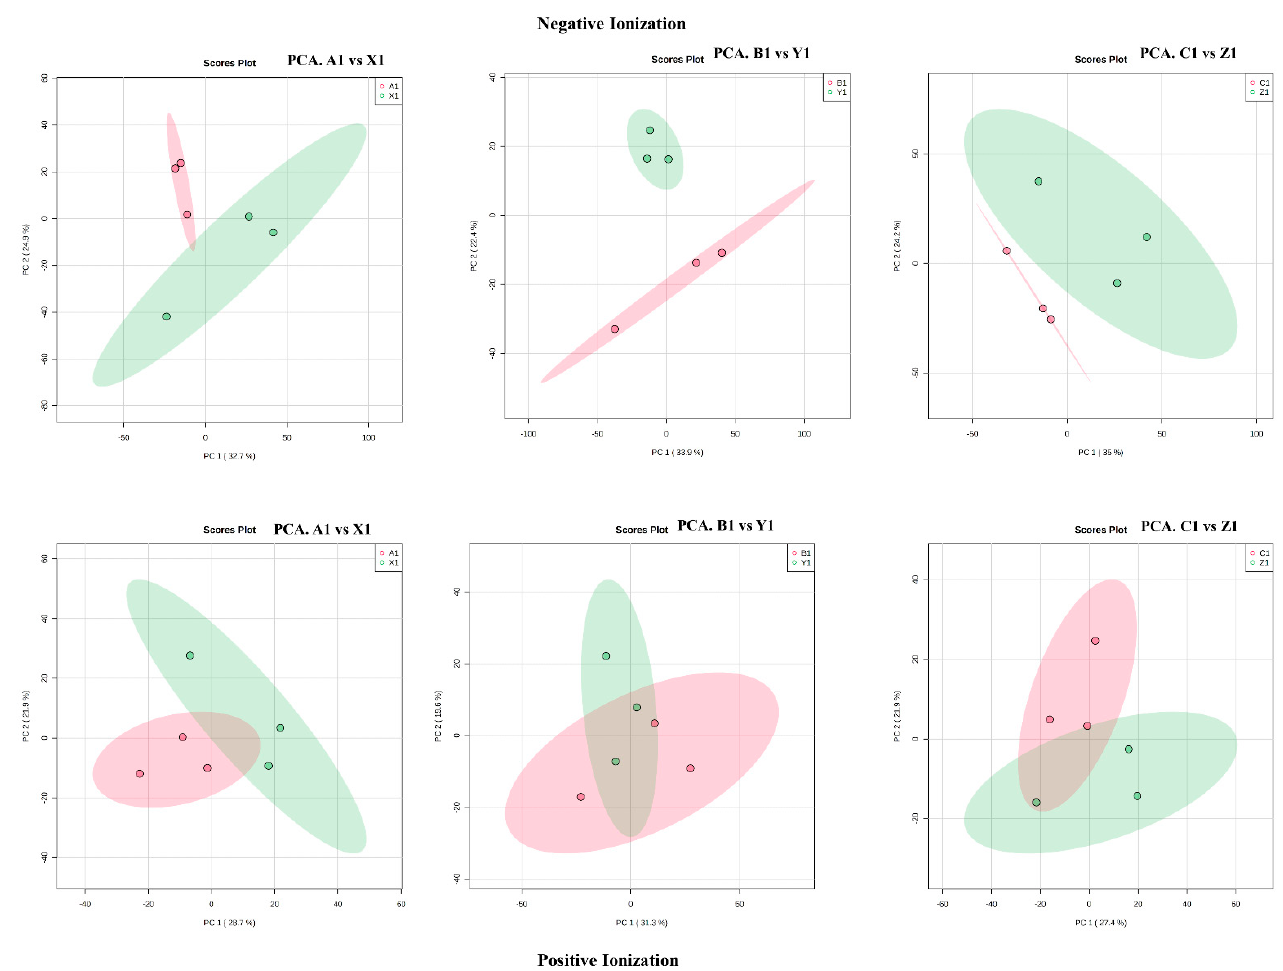
Figure 2. PCA scores plot showing statistically significant unsupervised separation between the metabolites of tolerant and sensitive genotypes .